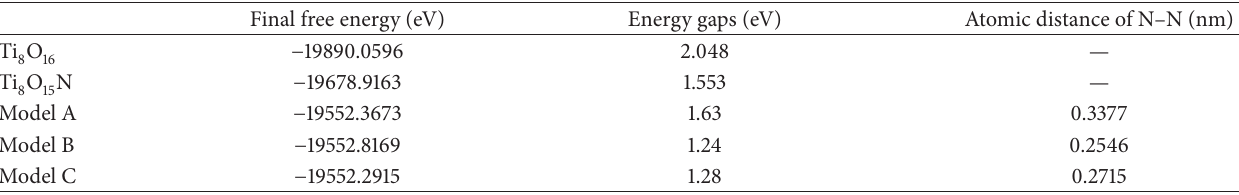
and the bond distance between the two doped N–N. 2